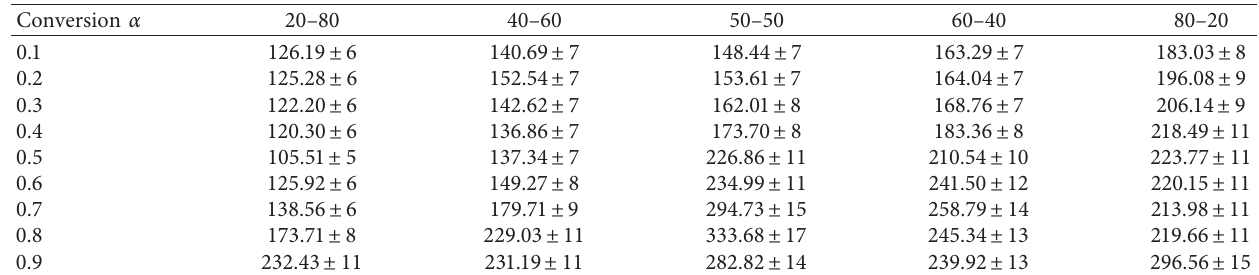
Table 6: Activation energies (KJ) by the KAS method for the PNVP- co -PHMA